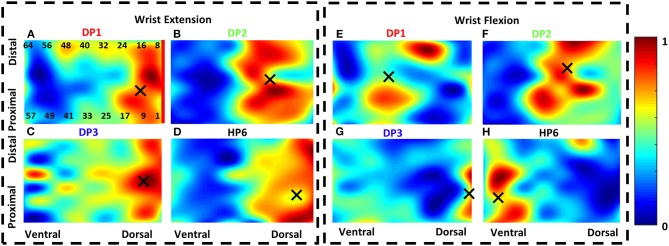
The heatmaps of two representative gestures for the three participants with Duchenne muscular dystrophy (DMD) and one healthy participant. (A–D) show wrist extension heatmaps for DP1 (A), DP2 (B), DP3 (C), and HP6 (D). (E–G) show wrist flexion heatmaps for DP1 (E), DP2 (F), DP3 (G), and HP6 (H). Regarding wrist extension, all participants exhibit similar activation patterns. However, for wrist flexion, there is higher variability in the activation patterns within participants. X marks show the center of gravity (COG) for each heatmap. Only the activations that are higher than 80% are used to calculate the COG.